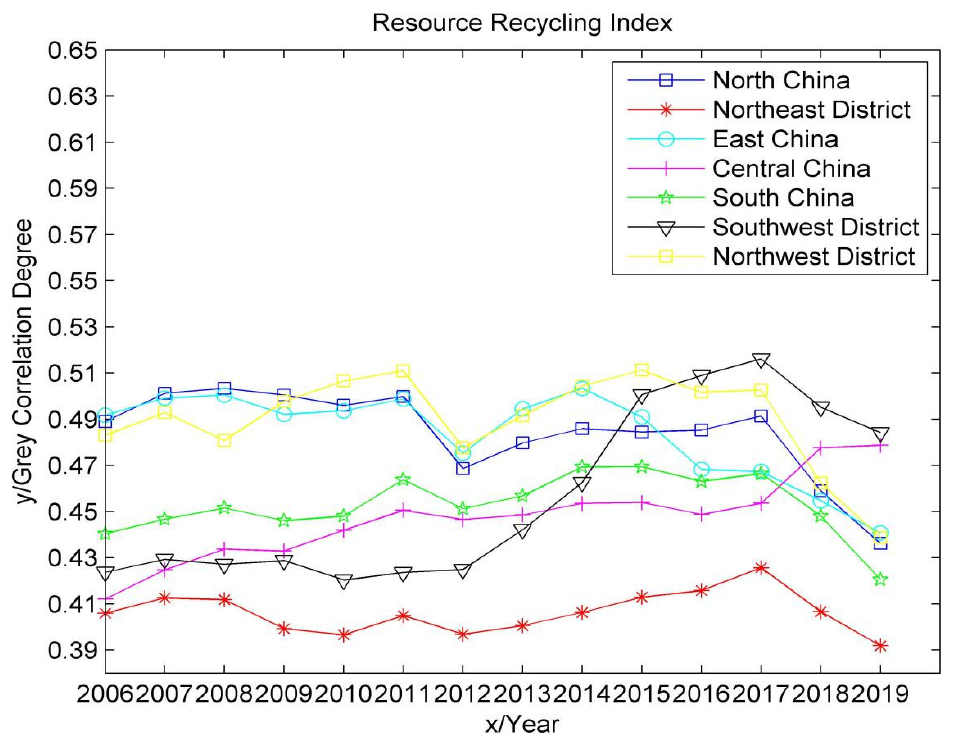
Figure 6. Time series trend of green agricultural resource-saving input indicators.